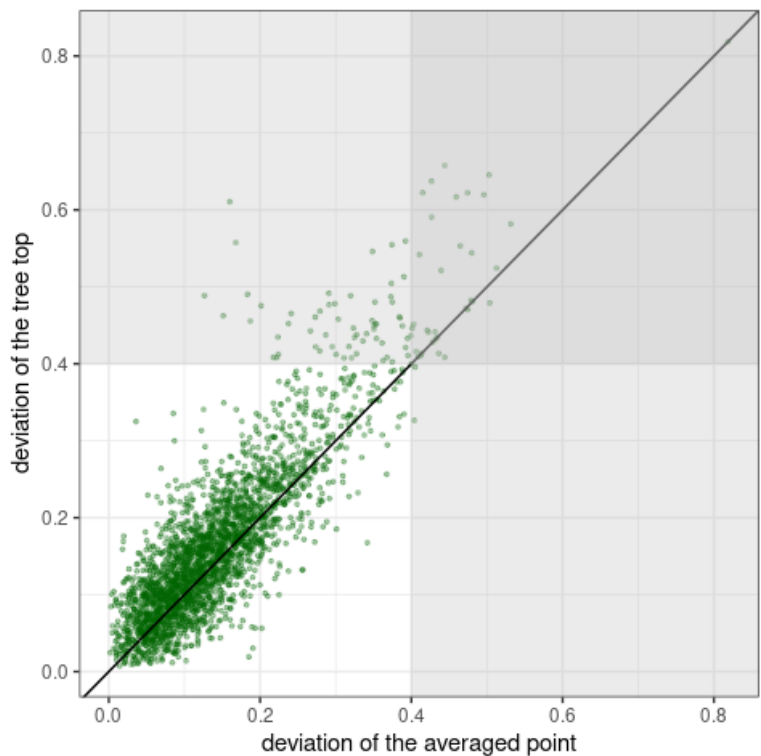
Figure 18. Horizontal deviations from the centroid of the segment of the highest reflection in the segment and averaged point above the 95th percentile of points’ height. The deviation is defined as the ratio of the distance between the centroid and the analyzed point and the pseudo-diameter of the tree crown-the diameter calculated from the segment area assuming circularity of the segment’s shape. The shaded area represents the distance of the point from the centroid of the segment by 0.8 pseudo-radius (0.4 pseudo-diameter).